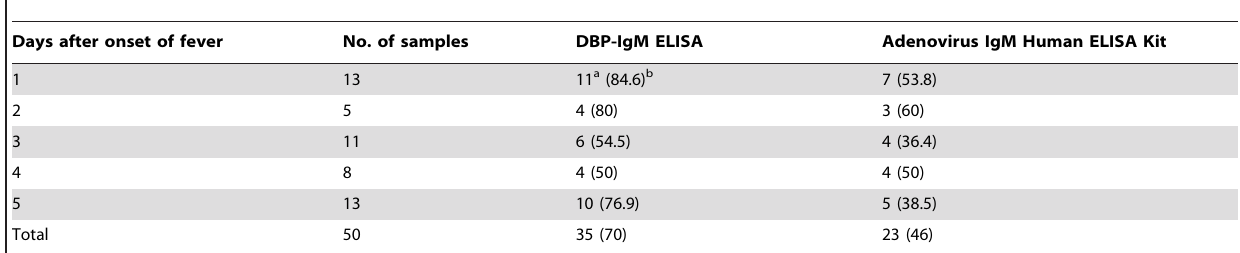
Table 2. Comparison of DBP-IgM ELISA and commercial Adenovirus IgM Human ELISA Kit in the diagnosis of HAdVs infection related to number of days after onset of fever.